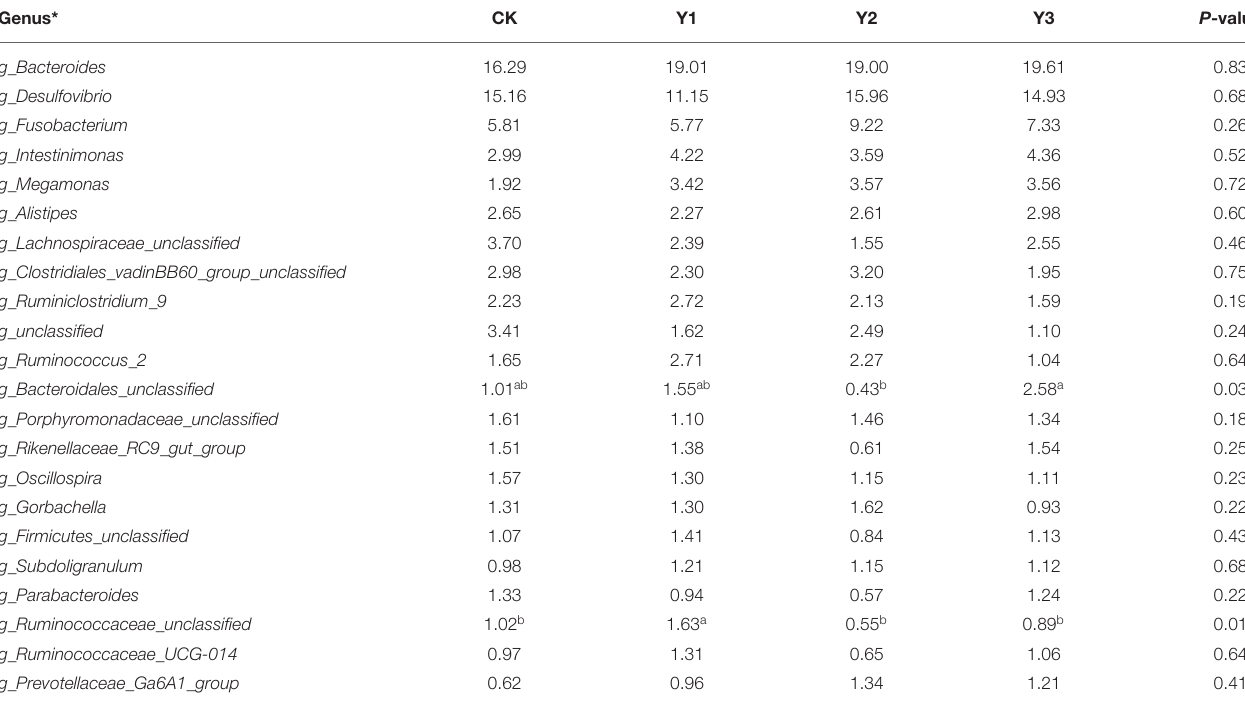
TABLE 4 | Effects of dietary AOE on genus-level relative abundances of the cecal microbiota in ducks (%). Genus* CK Y1 Y2 Y3 P -value